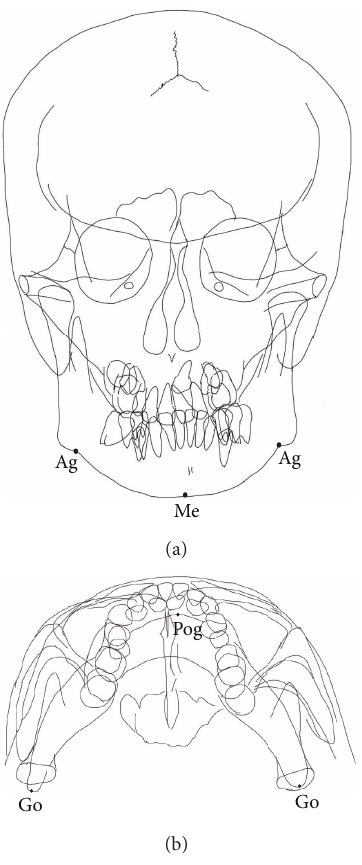
Figure 5: Trace of mandibular lines of this patient: (a) frontal cephalometric radiograph, (b) S-V cephalometric radiograph. Ag: antegonial tubercles; Mn: menton; Pog: pogonion; Go: